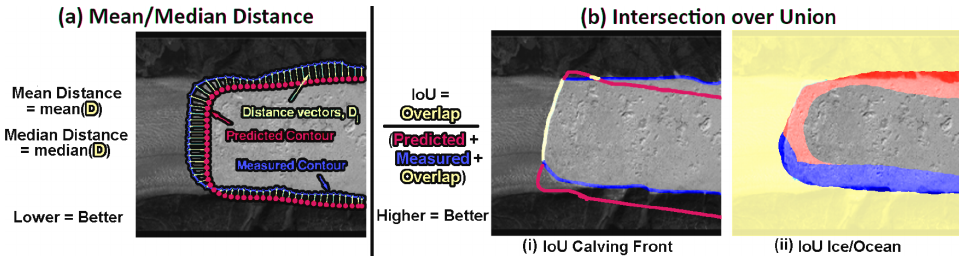
Figure 8. Error measures. (a) A visual outline of mean–median distance error estimation and (b) classification accuracy using intersection over union (IoU) for (i) the primary calving front and (ii) the secondary ice/ocean mask,